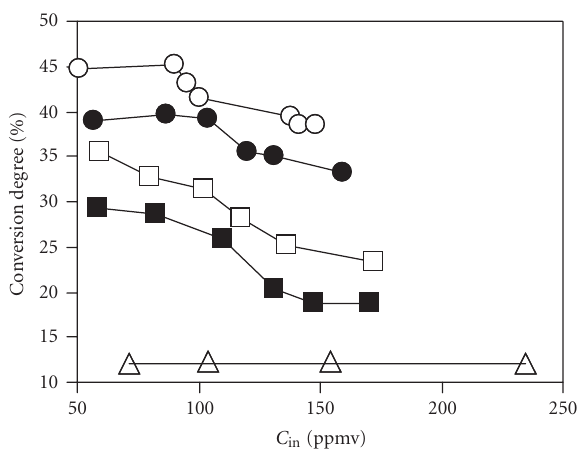
Figure 2: Conversion of DMA versus inlet concentration in PCO at ( (cid:2) ) 353 K, ( (cid:3) ) 373K, ( • ) 393 K, and ( ◦ ) 413K, and TCO at ( (cid:4) ) 573 K.